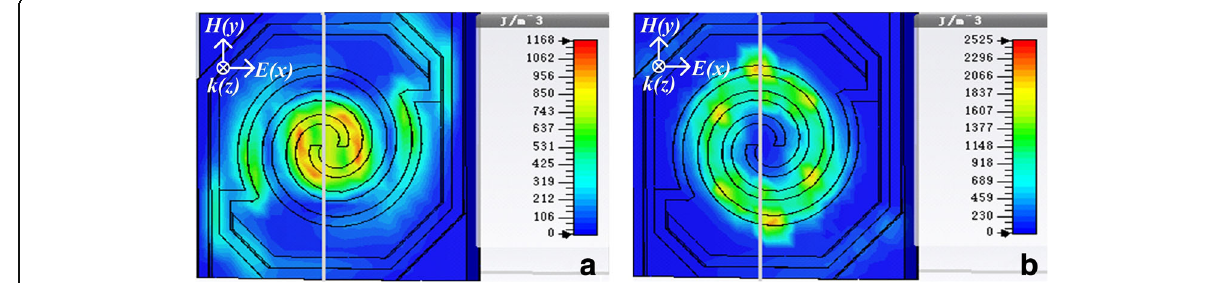
Fig. 9 Energy density diagrams of electric field ( a ) and magnetic field ( b ) for spiral-type antenna-coupled micro-bridge structures with two connected linear antennas on the bridge legs and a line width of 1 μ